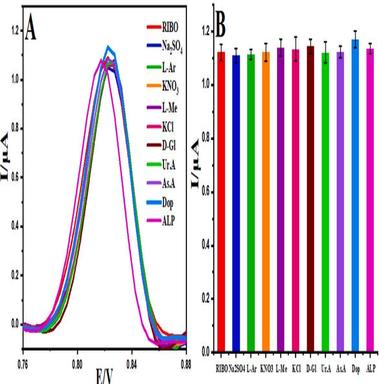
(A) DPV curves and (B) histogram of 1 μM RIBO at LaNiO3/g-C3N4@RGH/GCE/GCE in 0.1 M PBS (pH = 1.0) in the presence of an excess concentration of interfering species.